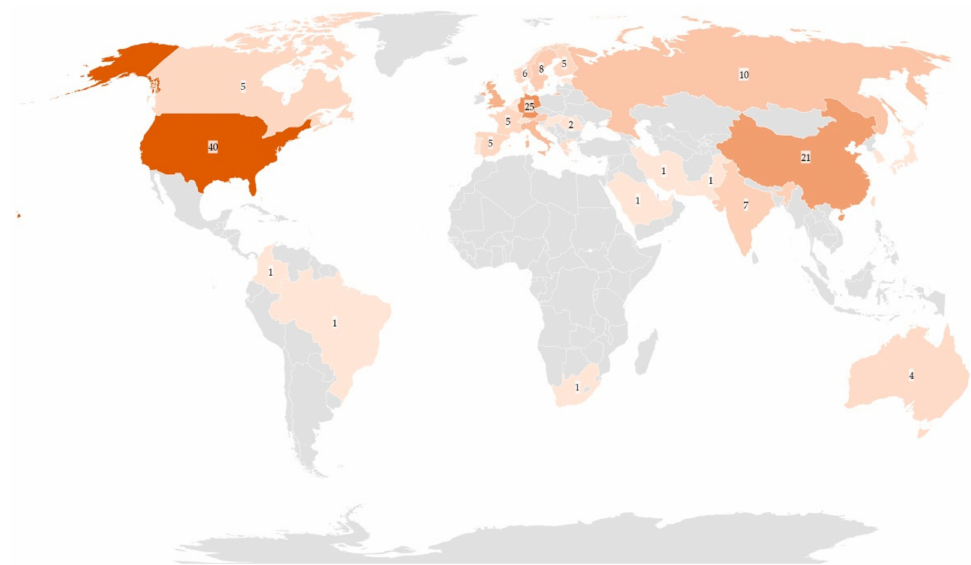
Figure 11. Map of affiliated countries publishing in the intersection of the DT and safety research fields. Table 4. Top ten most frequent index keywords in intersection of the DT and safety research fields.